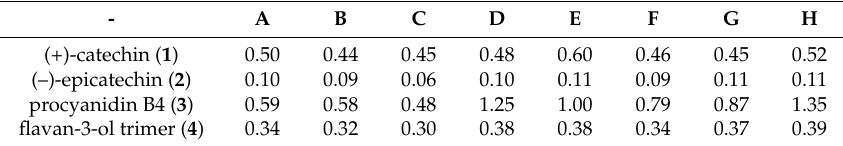
Data are means of three technical replications of each calculation based on HPLC measurements.